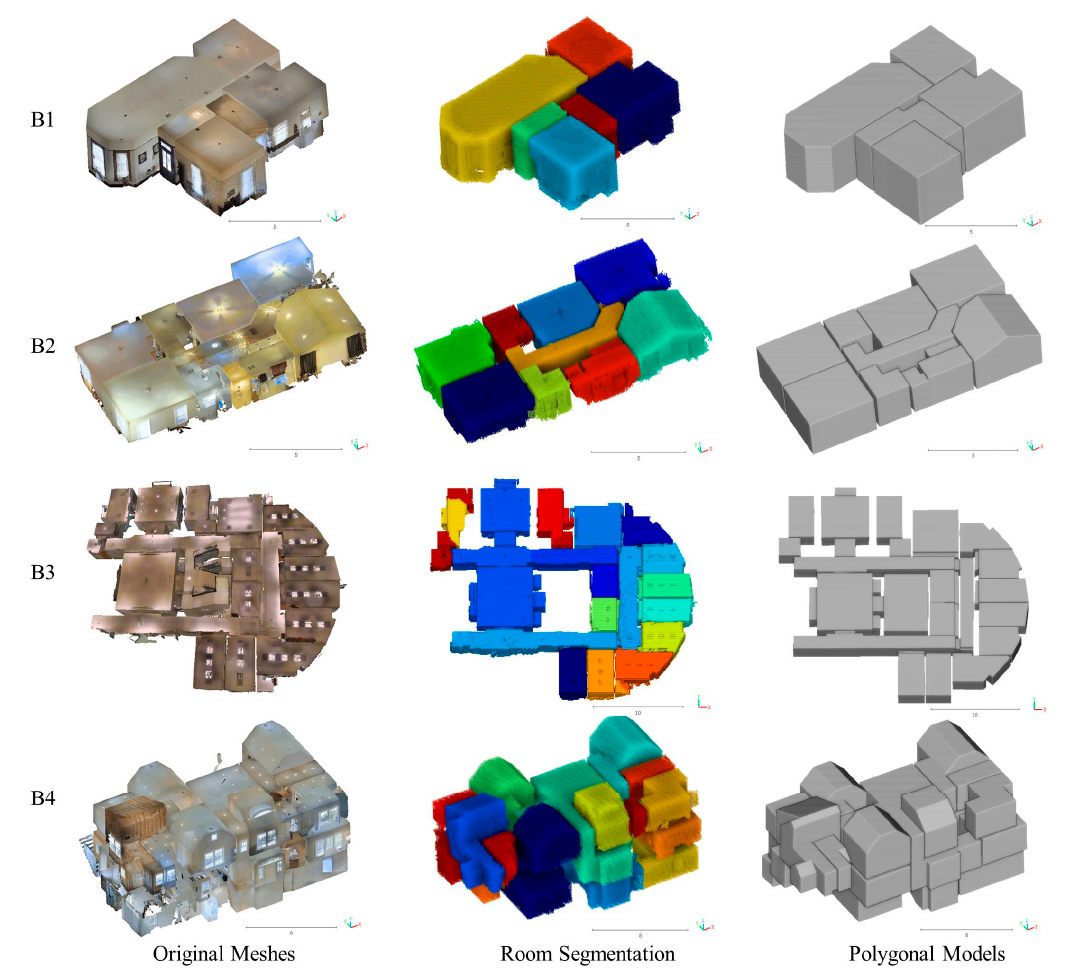
Figure 9. Experiments on mesh datasets. From left to right: Original point cloud, room segmentation result, reconstructed room layout for different meshes.